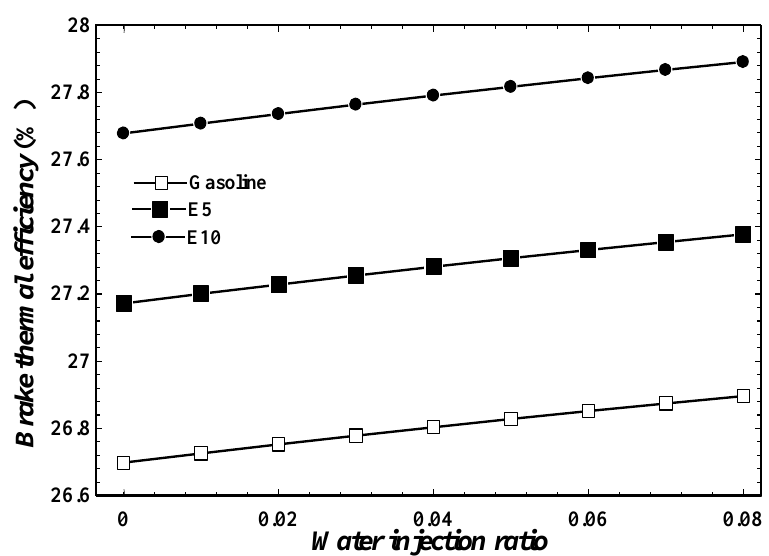
Figure 8. Engine brake power efficiency in various water injection ratios for each fuel.